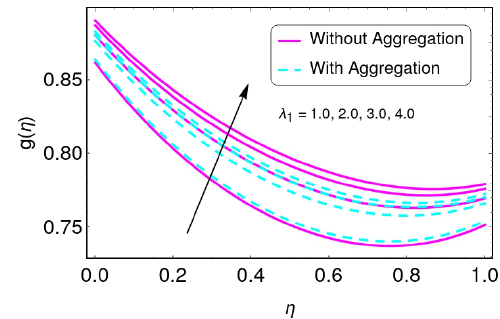
Figure 13. Characteristics of λ 1 for g (cid:48) .